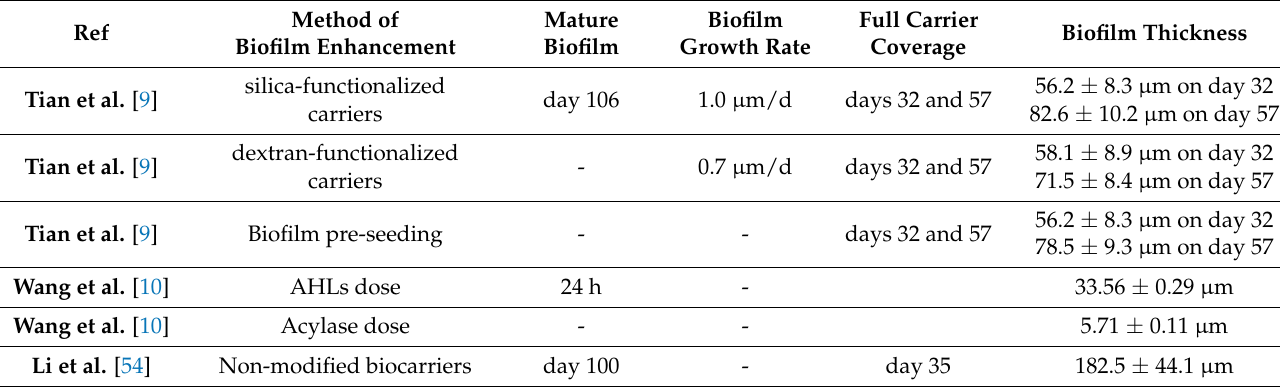
Table 3. Comparison of different methods used to enhance biofilm